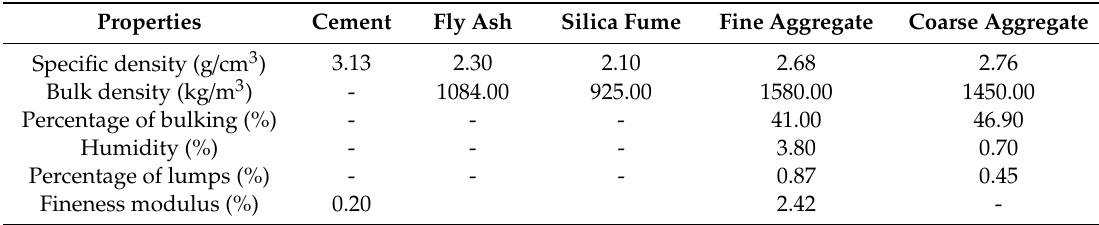
Table 1. The material properties.